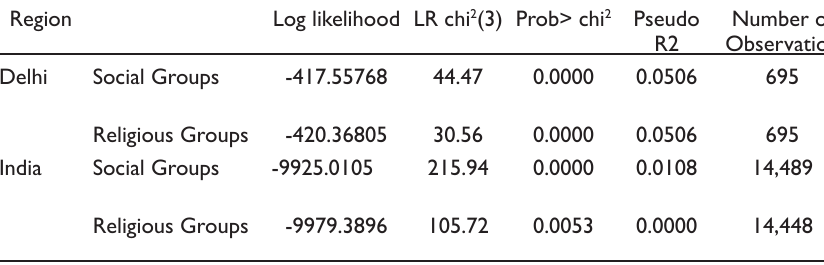
Table 3. Model Filling Information for India and Delhi Region